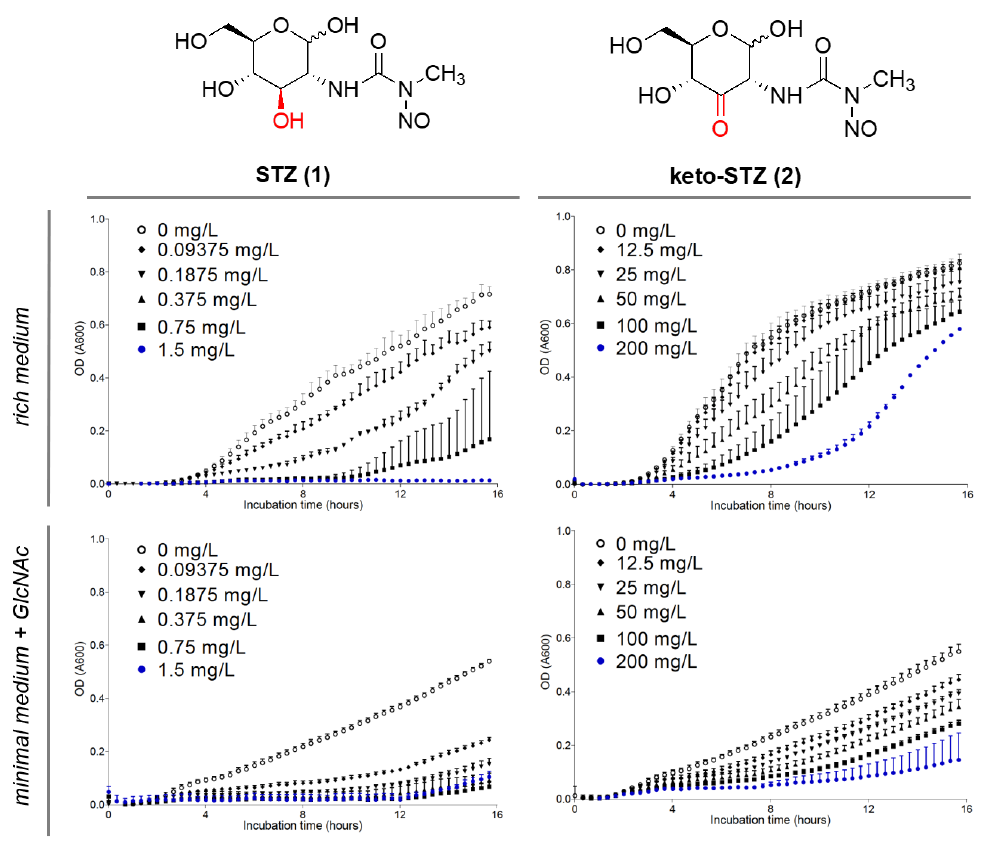
Figure 2. Growth curves of E. coli to determine the MIC value for STZ 1 ( top left ) and keto-STZ 2 ( top right ) in rich medium, and for STZ 1 ( bottom left ) and keto-STZ 2 ( bottom right ) in minimal medium + GlcNAc. Experiments are performed in triplicate.